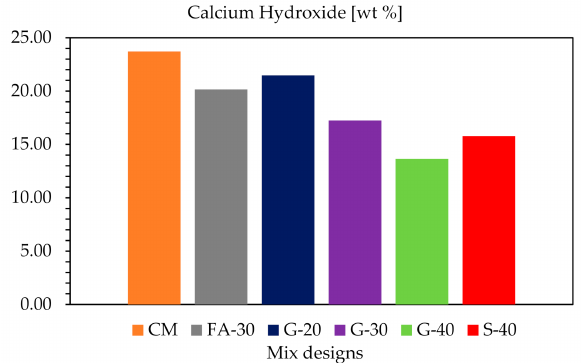
Figure 17. Calcium hydroxide for all pastes at 100